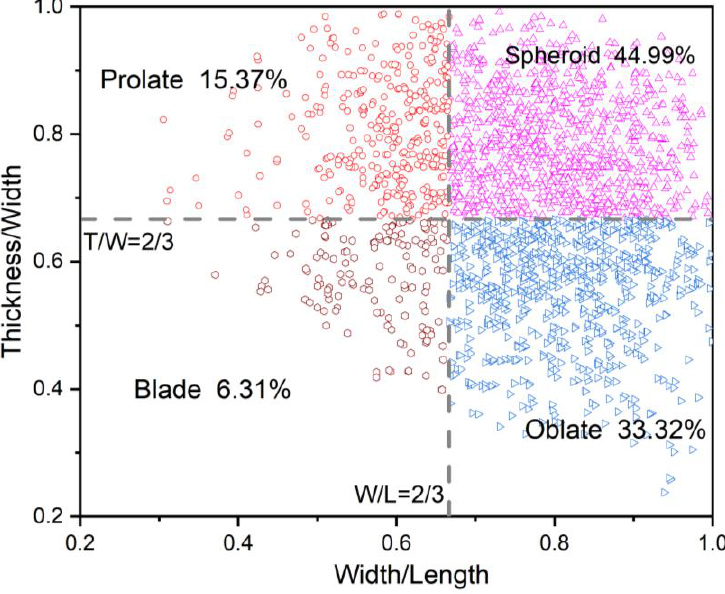
Figure 12. Aspect ratios of measured particles.